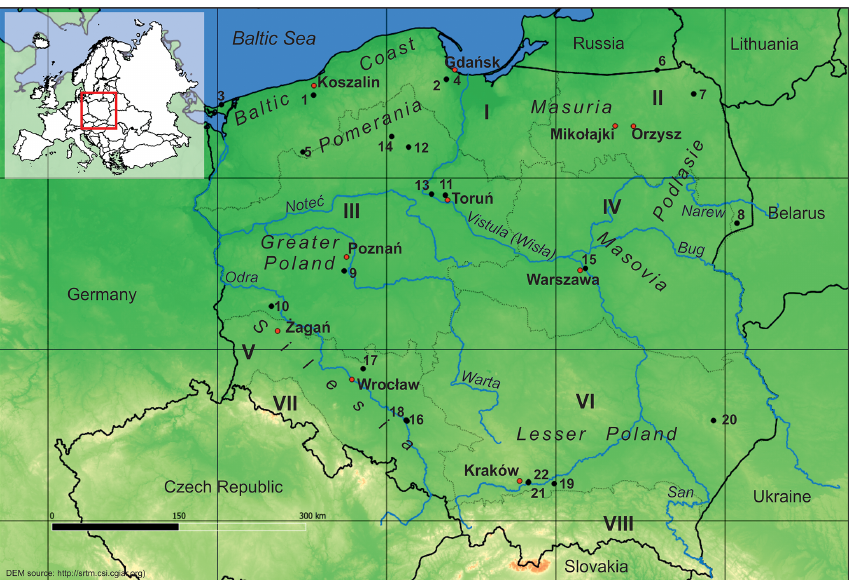
Figure 1. Location of dendrochronological sites and natural-forest regions (black dots and black dotted lines, respectively; for more details see Table 1) as well as meteorological series (red dots) and geographical regions (for more details see Table 2) used in the